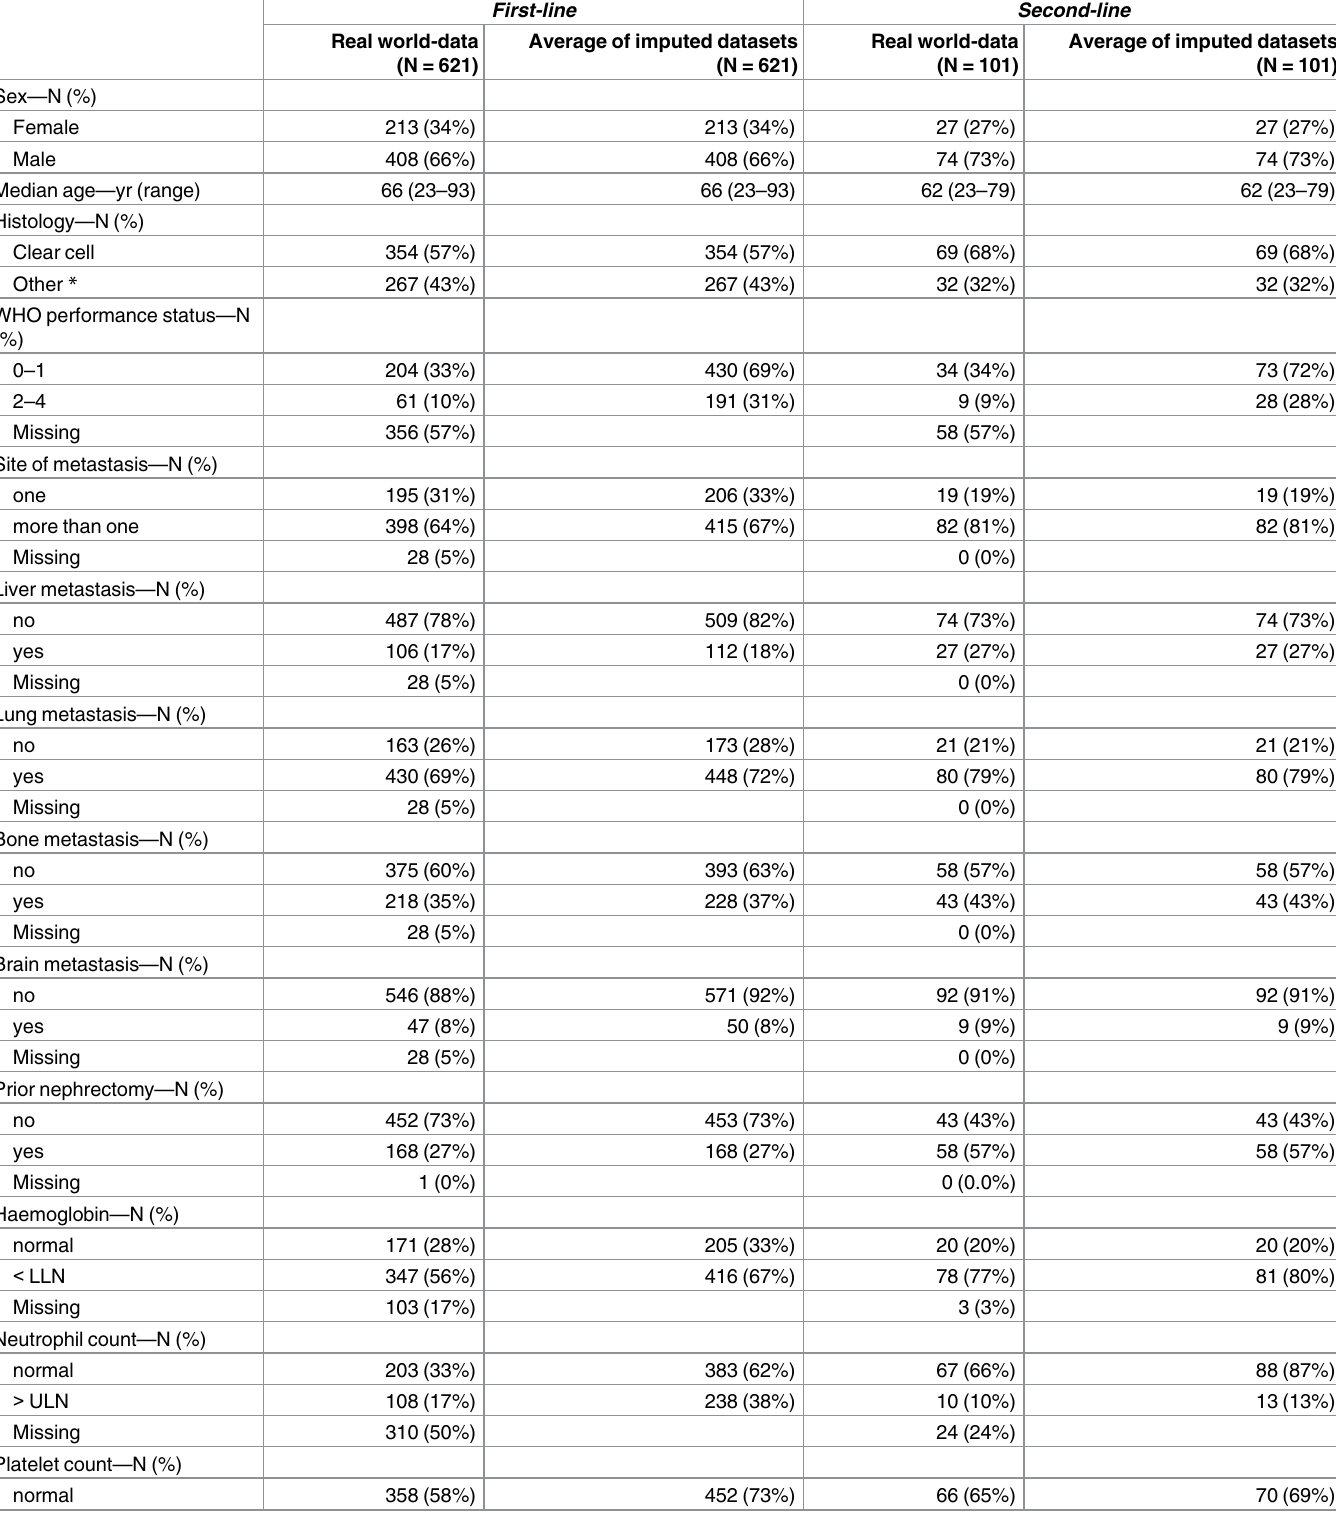
Table 1. Patient and disease characteristics before start of first- and second-line